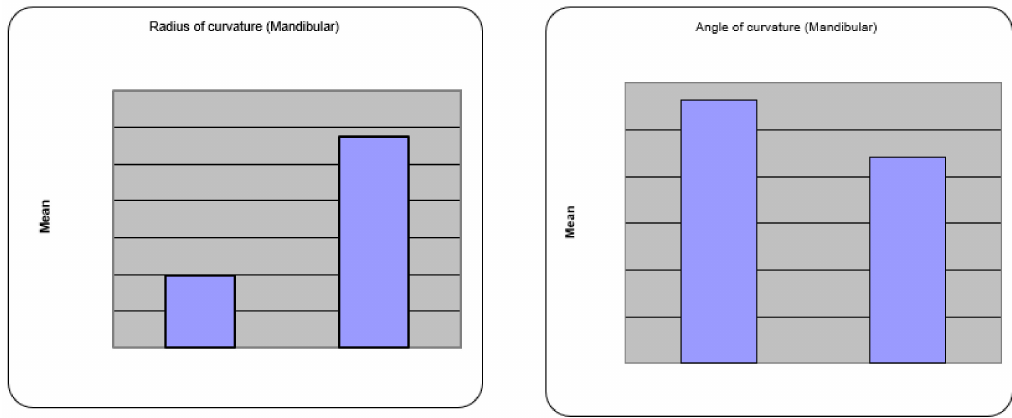
Figure 4. Radius of curvature, angle of curvature (Mandibular).